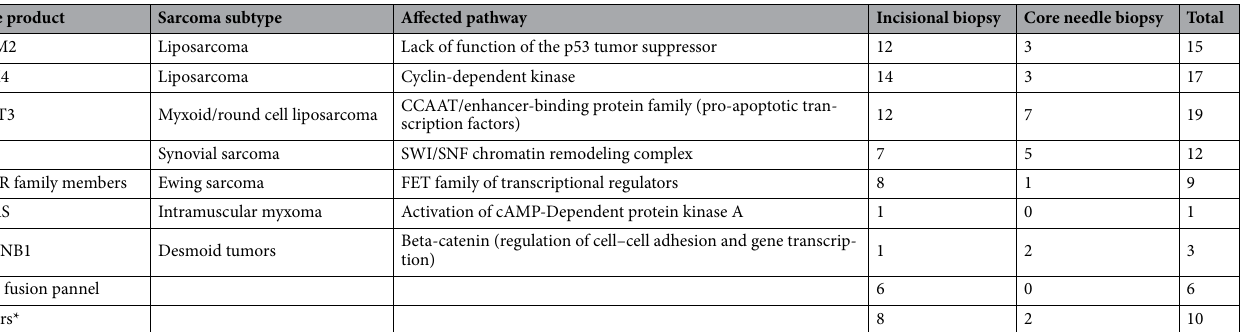
Table 4. Overview of genes targeted by molecular diagnostics in this study. *EBV, BCL family members, Myc, USP6.